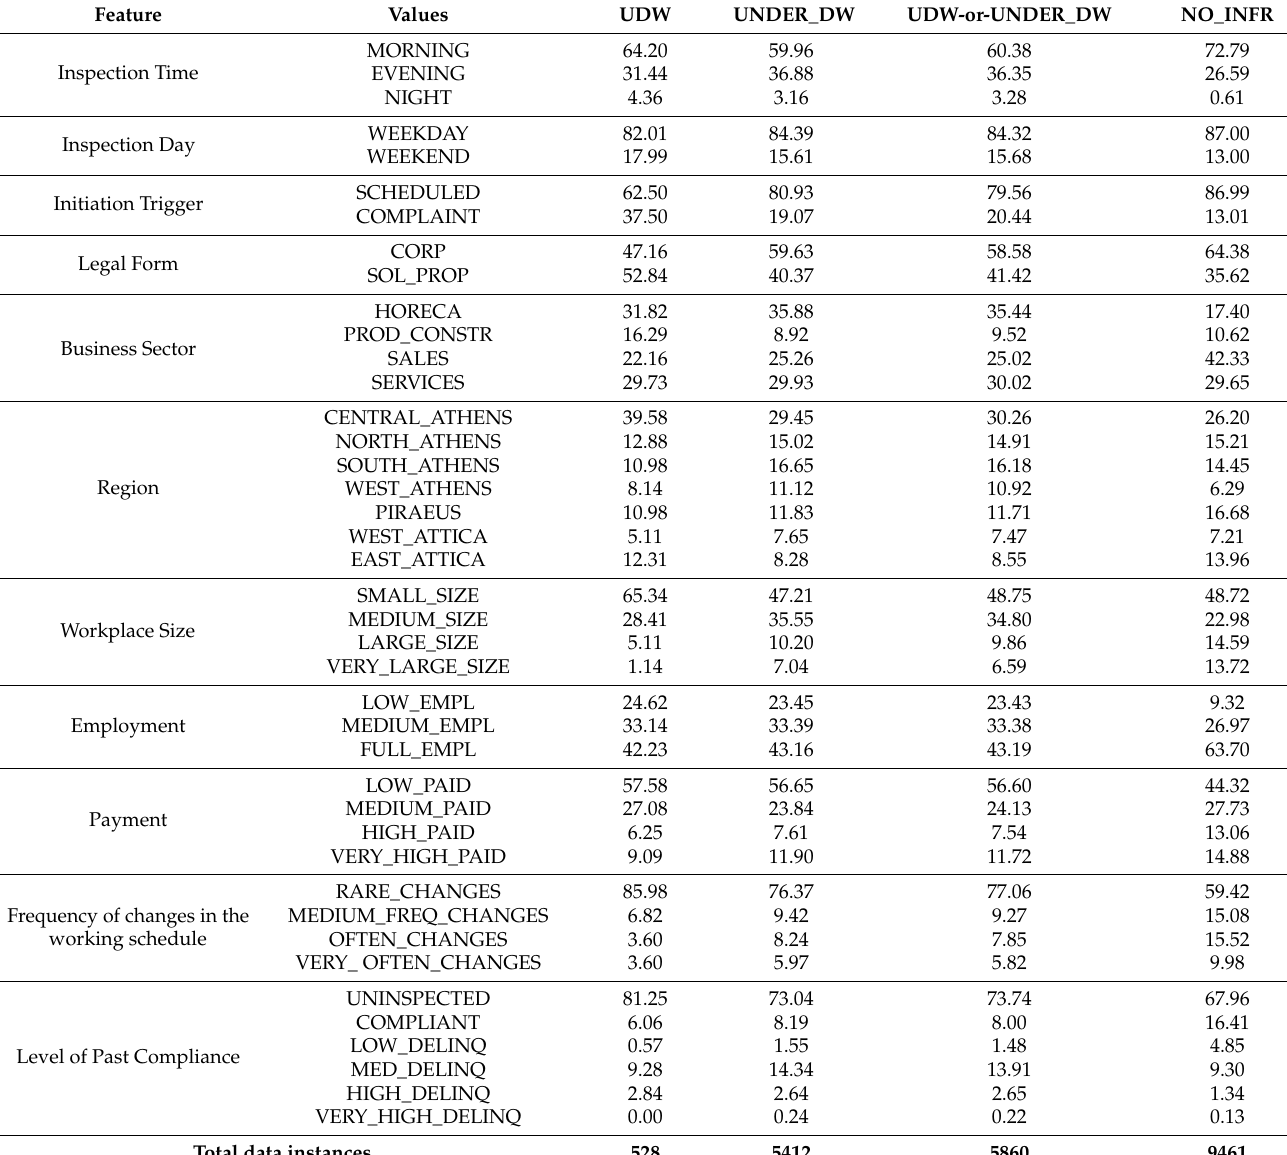
Table 2. Groups of inspection cases per targeting and their ratios per feature